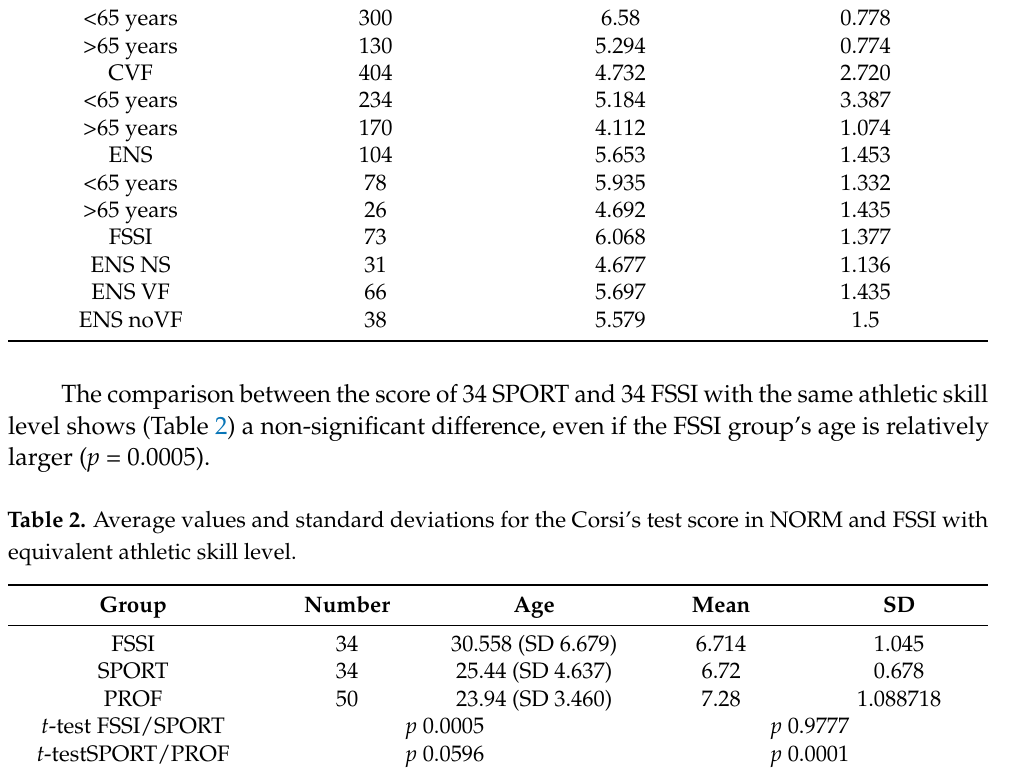
Table 1. Average values and standard deviations for the Corsi’s test score in the various groups. Group Number